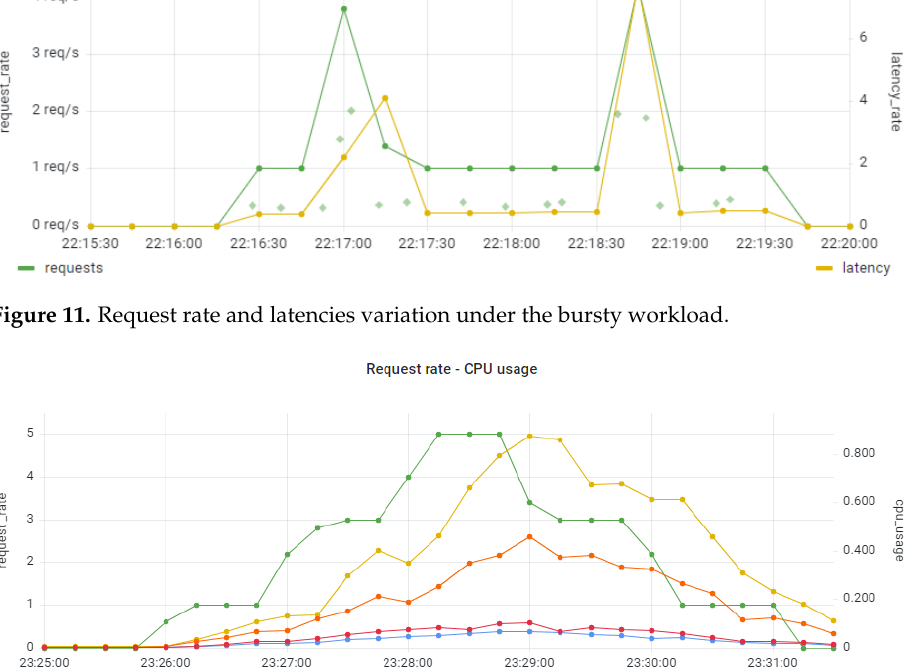
Figure 12. CPU usage per application component under the smooth workload.